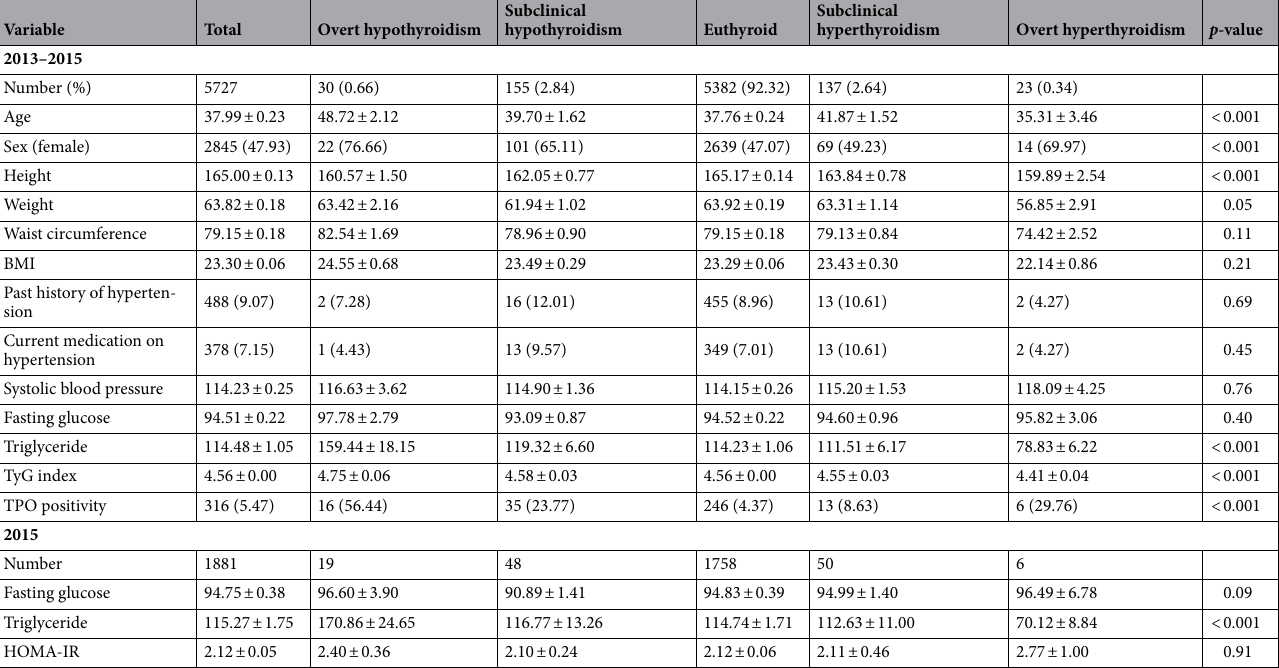
Table 1. Baseline characteristics of subjects according to thyroid dysfunction. BMI body mass index, TyG index triglyceride glucose index, TPO thyroid peroxidase antibody, HOMA_IR homeostasis model assessment of insulin resistance.